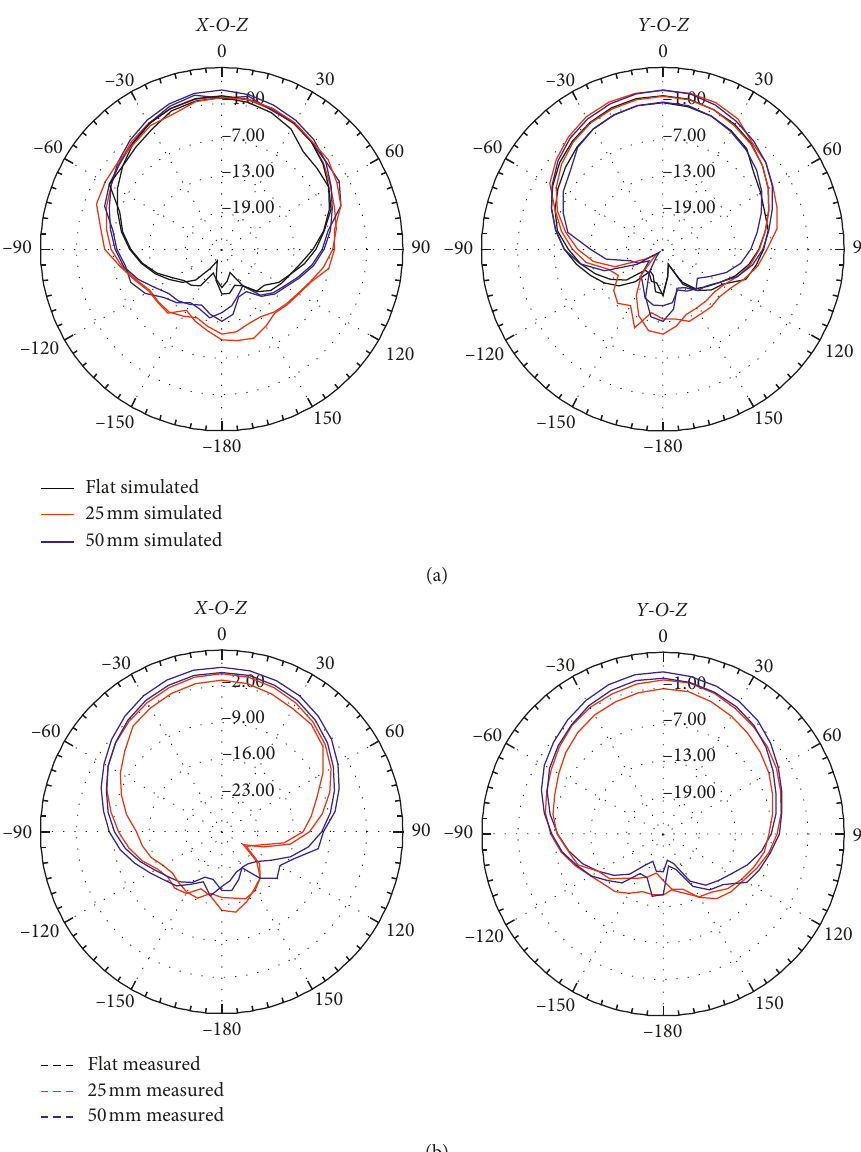
Figure 11: Simulated and measured radiation patterns in different bending directions: (a) x and (b) y . All the values are in